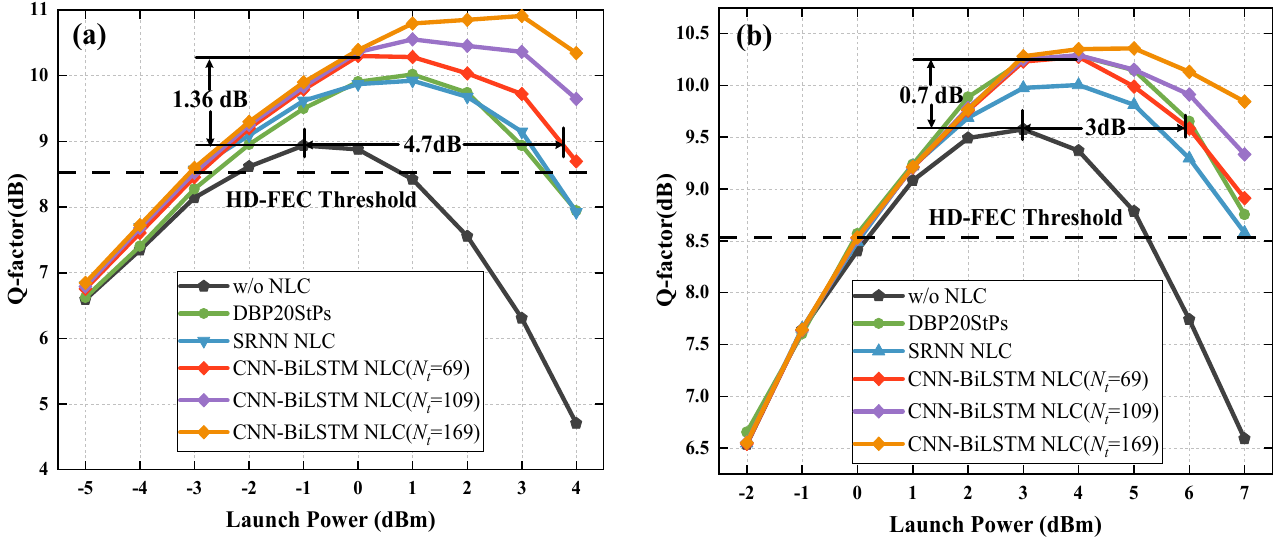
Figure 8. Q-factor of different NLC schemes versus launch power for SC systems. ( a ) 28 GBaud PDM-16QAM after 1600 km transmission; ( b ) 85 GBaud PDM-64QAM after 400 km transmission.